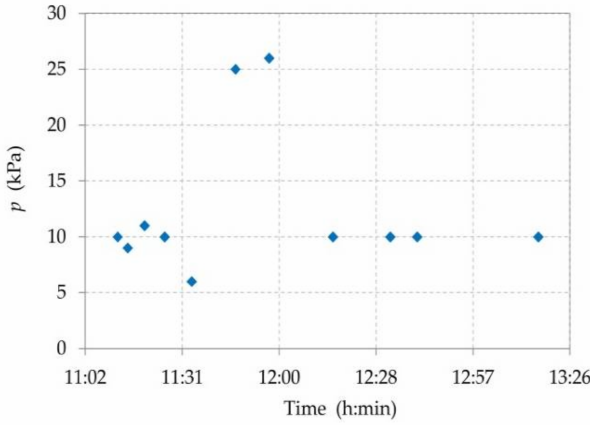
Figure 6. Relative gas pressure at the inlet to the